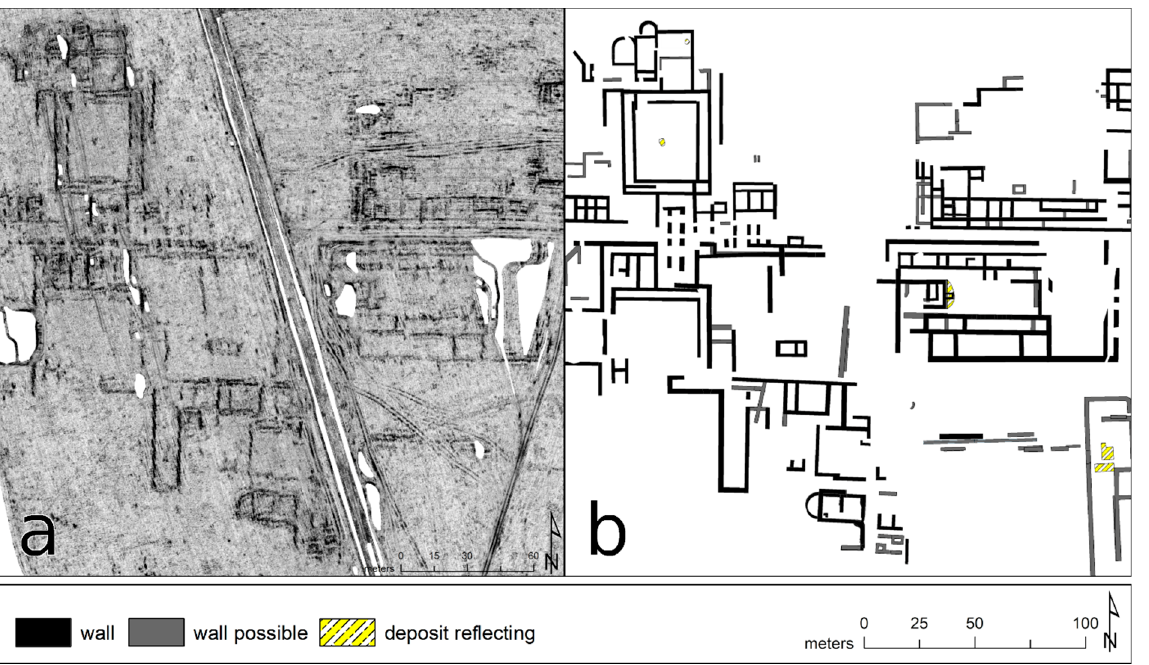
Figure 14. ( a ) Detail of the GPR data as depth-slice of the approximate depth range (0.8, 1.2) m. ( b ) Corresponding archaeological interpretation of all GPR depth-slice images. The label “deposit reflecting” marks observed reflective structures that could not be assigned unambiguously yet but were deemed relevant to the general interpretation.